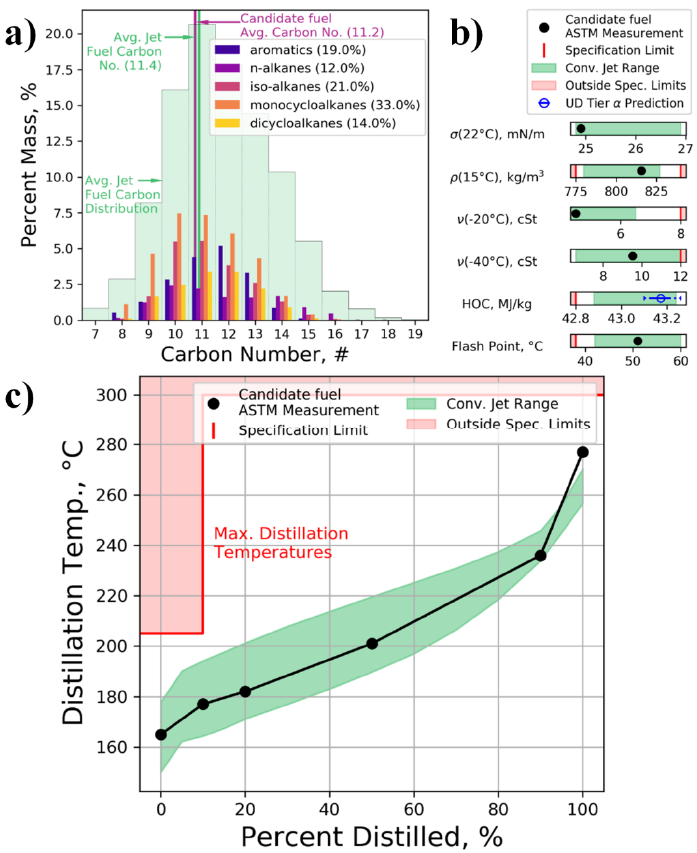
Figure 1. Results of SAF candidate testing (NiMo:S1(JFC)): ( a ) hydrocarbon type analysis result, with comparison to an average conventional jet fuel (green region); ( b ) critical jet fuel properties as predicted (Tier α ) and measured (Tier β ), with comparison to the specifications for Jet A–1; ( c ) distillation curve, with comparison to the collective analysis of 3 aviation fuels (POSF 10325, 10264, and 10289)